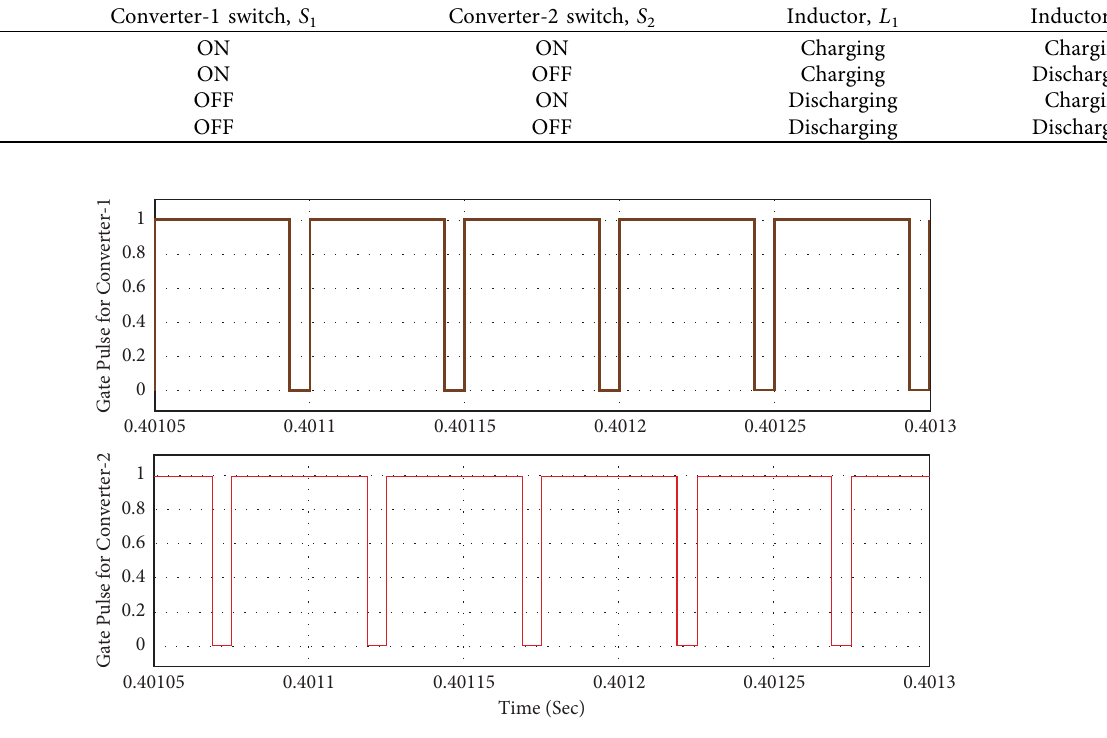
Figure 9: Pulse generation.